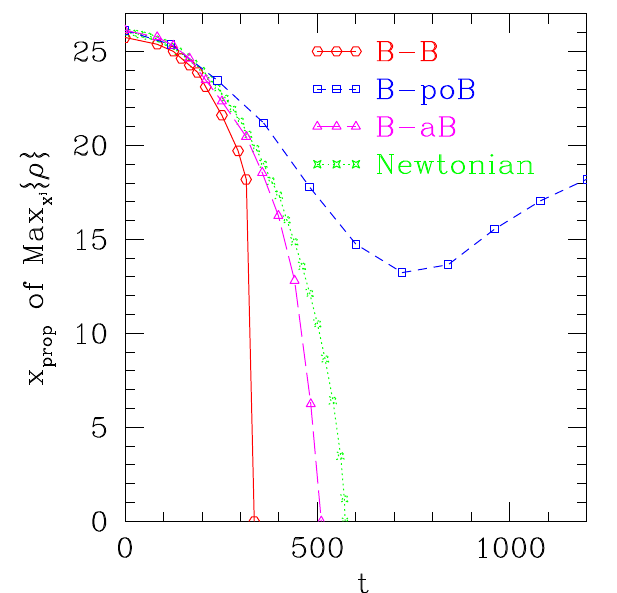
Fig. 18 The position of the center of one BS in a head-on binary as a function of time for (i) [B-B] identical BSs, (ii) [B-poB] opposite phase pair, and (iii) [B-aB] a boson–anti-boson pair. A simple argument is made which qualitatively matches these numerical results, as discussed in Sect. 4.2. Also shown is the expected trajectory from a simple Newtonian two-body estimate. Reprinted with permission from Palenzuela et al. (2007); copyright by